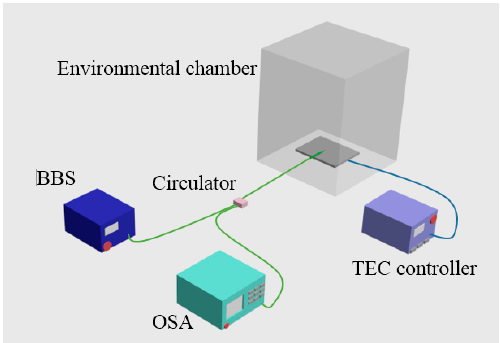
Figure 23. Experimental setup for studying the temperature dependence of an SPST.